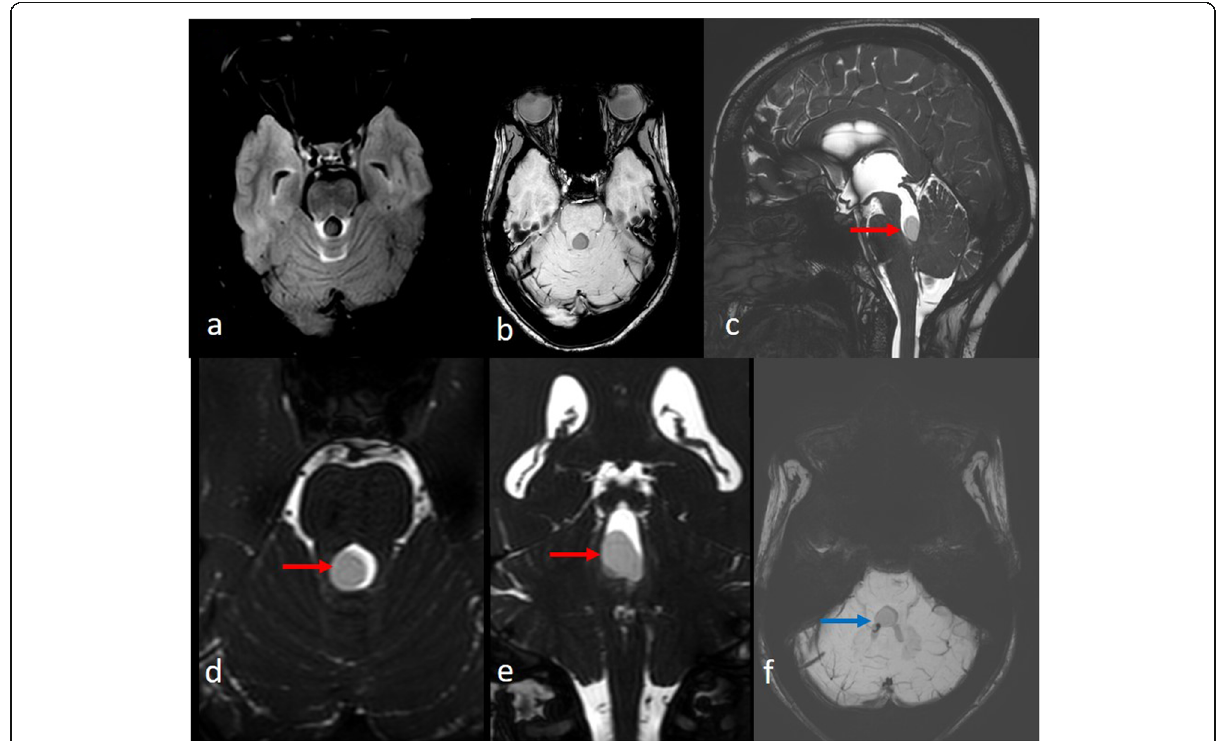
Fig. 1 Multimodal magnetic resonance imaging brain axial images ( a , b ) showing cyst in the 4th ventricle, constructive interference in steady state 3 dimensional CISS3D sequence-sagittal, axial, and coronal ( c – e ; red arrow) delineating the cyst in 4th ventricle, and there is evidence of blooming on susceptibility images( f ; blue